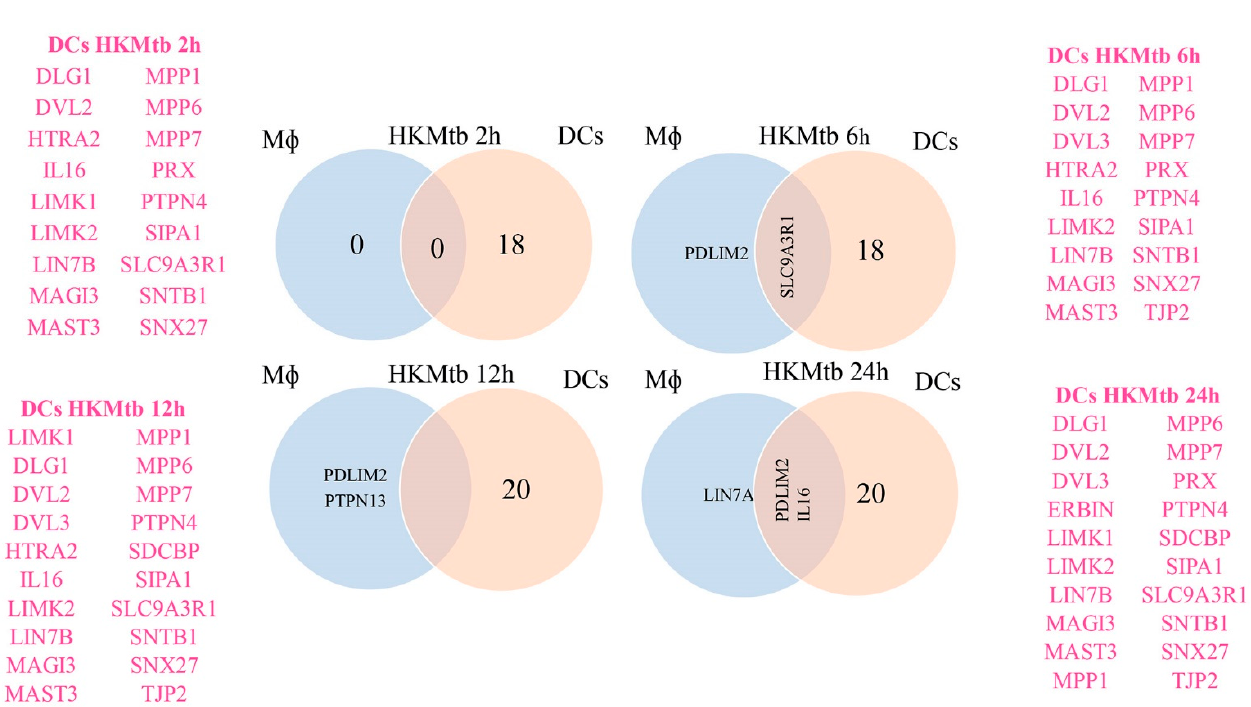
Figure 6. Differential expression of PDZ genes upon stimulation with HKMtb in M φ and DC. Venn diagram showing DEGs sharing by both APCs at specific time points during the entire time course stimulation by HKMtb.